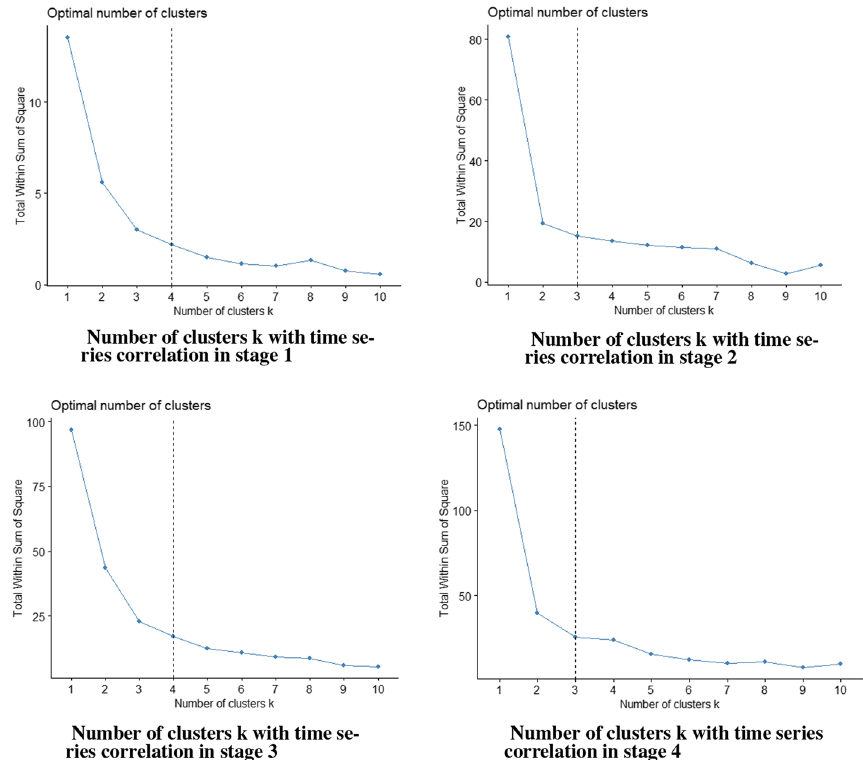
Fig. 8 Number of clusters k with time series correlation